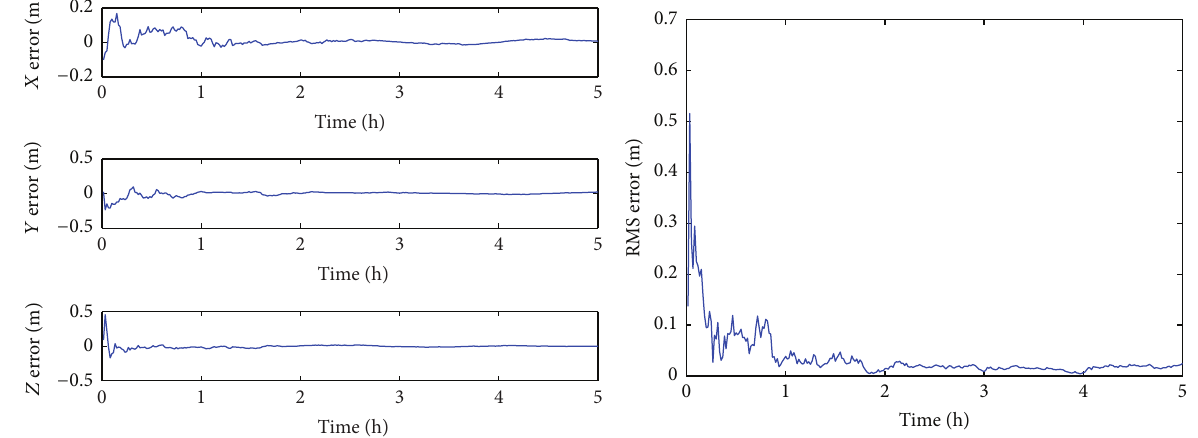
Figure 7: Error of absolute position estimation for satellite 3 using